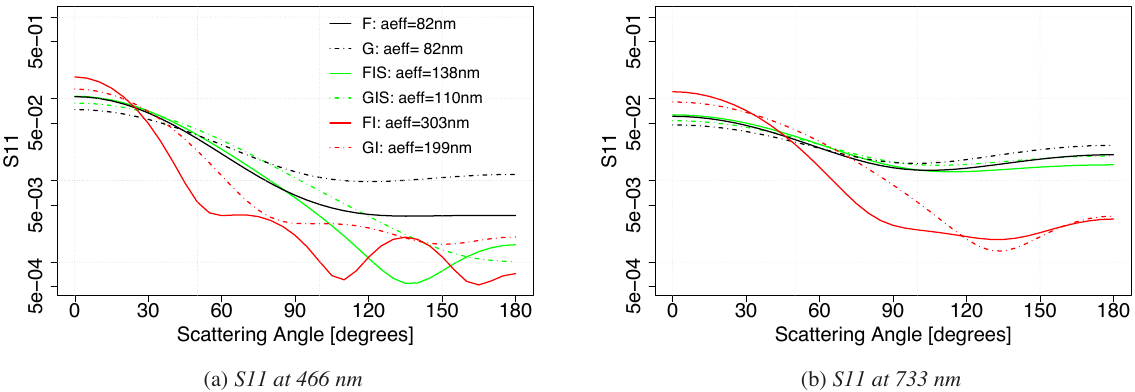
Fig. 8. Scattering phase function at 466nm (a) and 733nm (b) . Characteristics of the bare BC (cases F and G) and mixed BC-NaCl (cases FI, GI, FIS, and GIS) are described in Table 2 and Figs. 5, and 6. A scattering angle of 0 degrees corresponds to radiation that is scattered in the forward direction (i.e., in the same direction as the incident radiation). A scattering angle of 180 degrees is backscattering. The coated aggregates are departing from the Rayleigh regime, and therefore display some angular variation, with forward scattering increasing.